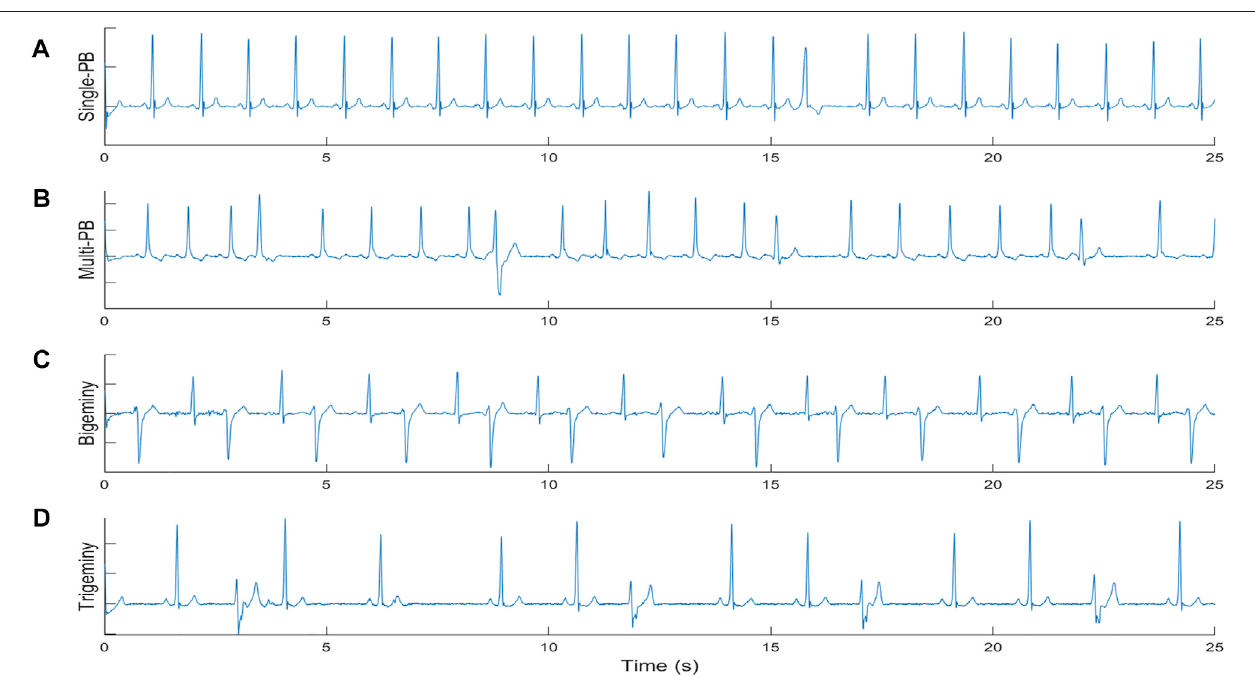
FIGURE 1 | The de fi nition of different premature beats types. (A) single premature beat; (B) multi premature beats; (C) Bigeminy; (D) Trigeminy.